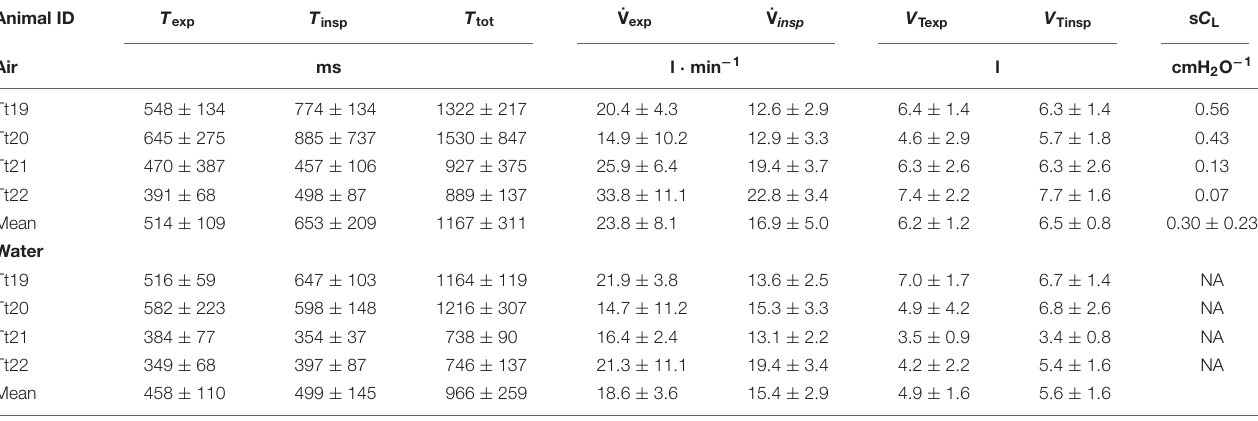
TABLE 2 | Animal identification, expiratory ( T exp ), inspiratory ( T insp ) and total breath duration ( T tot ), expiratory and inspiratory flow (˙V exp and ˙V insp ) and tidal volume ( V Texp and V Tinsp ), specific dynamic lung compliance (s C L ).